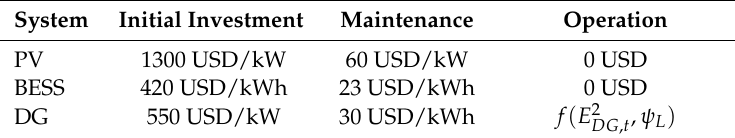
Table 2. Unitary system costs for simulations.